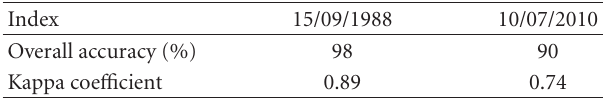
Figure 3: The correlation coe ffi cients between the integrated NDVI in the growing season and the accumulated precipitation over the same period. The significance of correlation model was at the 0.05 level. Where NDVI showed significant increase trend, the correlation coe ffi cients were not significant (Banner or county ids: 24, 29, 30, 32, 34, 35, 36, 39, 42,47,50, 53, 55, 56, 61, 64, 69, 70, 71, 72, 73, 74, 75, 76, 79, 81, 82, 83, 85, 87, 88), while where NDVI showed no significant change trends, the correlation coe ffi cients were significant (Banner or county ids: 6, 8, 9, 10, 11, 12, 16, 21, 23, 26, 27, 37, 38, 41, 48, 43, 45, 53, 55, 56, 65, 63, 62, 58, 48). Table 5: The overall accuracy of the moving sand dune Table 4: The slope and F -statistics value of linear regression model of millet yield per unit ( t/ha × 10 4 ).